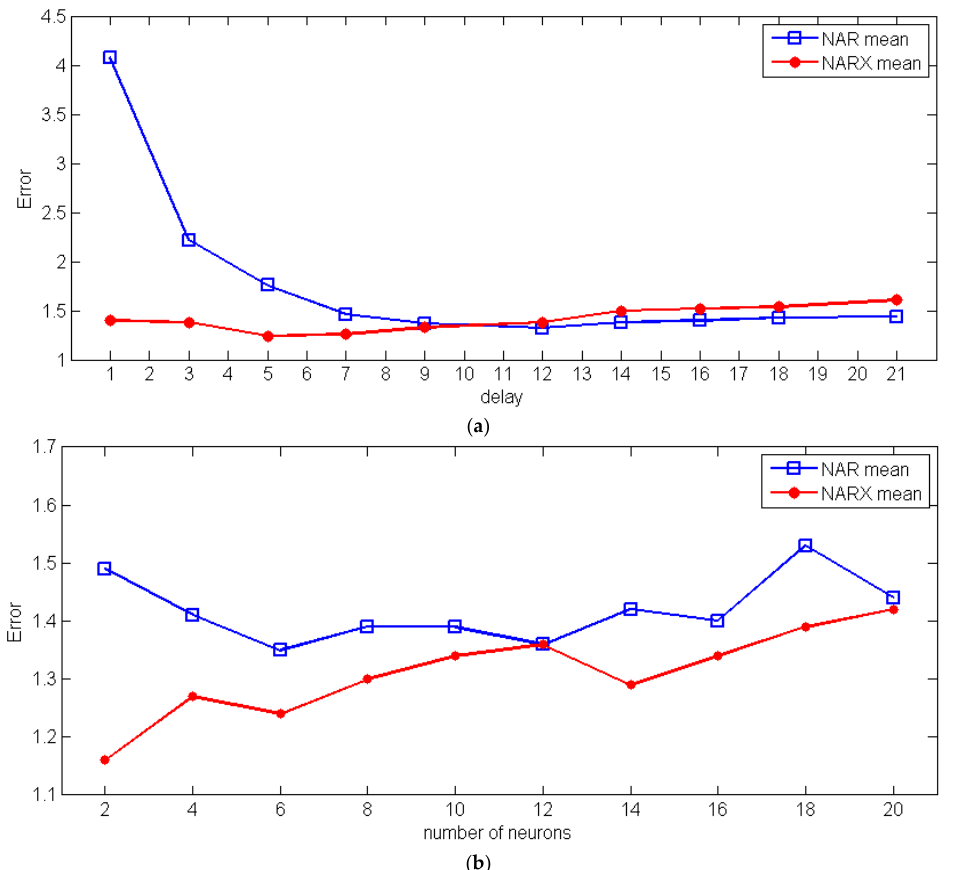
Figure 12. Best prediction ( a ) and worst prediction ( b ) of the next 100 days for the normalized data of energy consumption of Building 5 using NARX model.